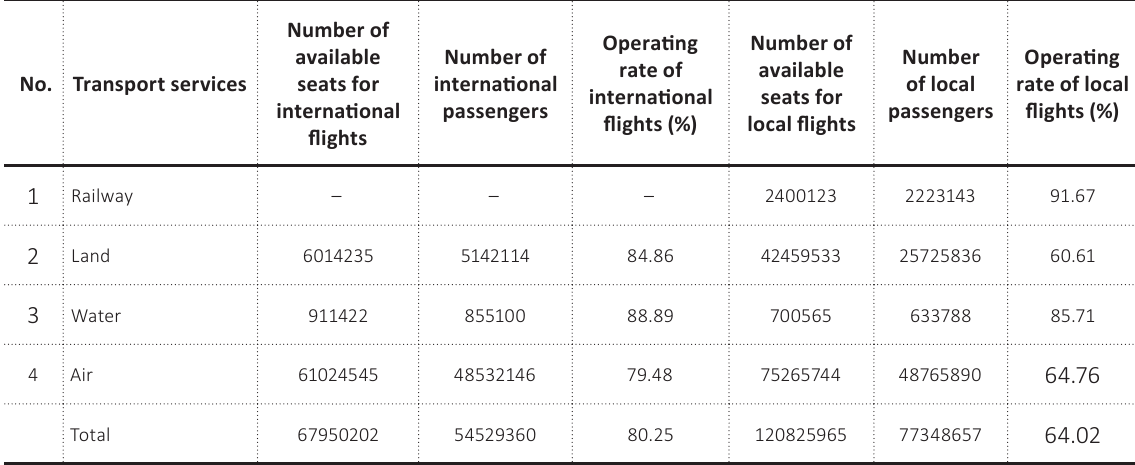
Source: General Authority for Statistics (2018).